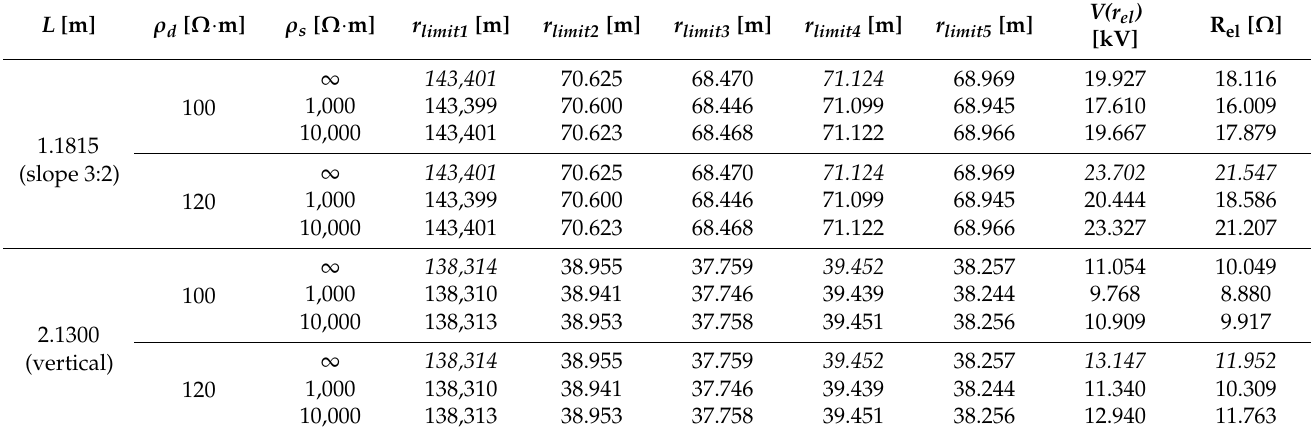
Table 6. Minimum values of distances for absolute potential in relation to remote earth, for potential gradient/electric field strength in steady and transient state, absolute potential at electrode surface and equivalent electrode resistance in the area of Stachtoroi (Attica) in relation to neighboring coasts based on the method “C” according to Equations (55) and (56),